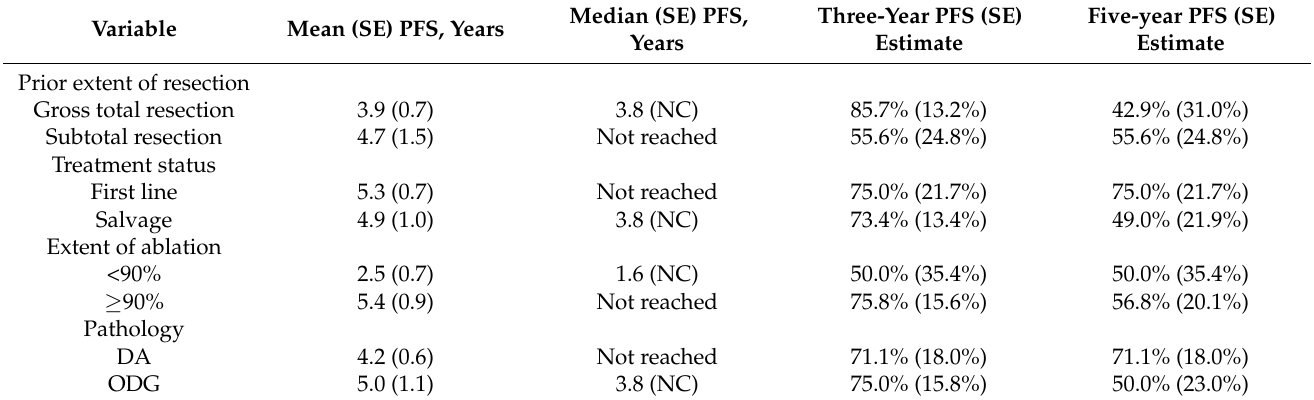
Table 4. PFS stratified by extent of resection, treatment status, extent of ablation, and